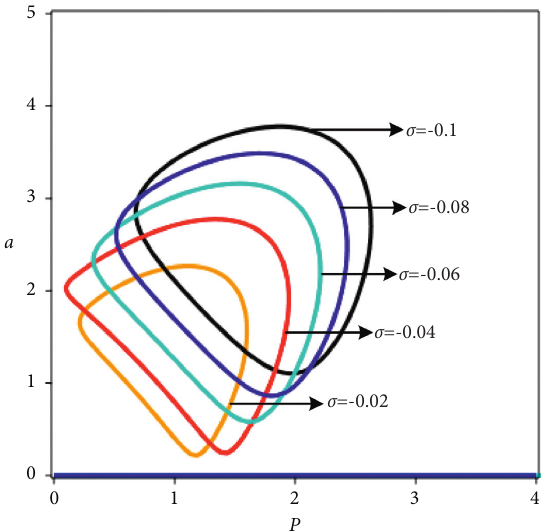
Figure 15: The curves of excitation amplitude P and response amplitude ( a ) of 1/3-order subharmonic resonance (varied σ ).